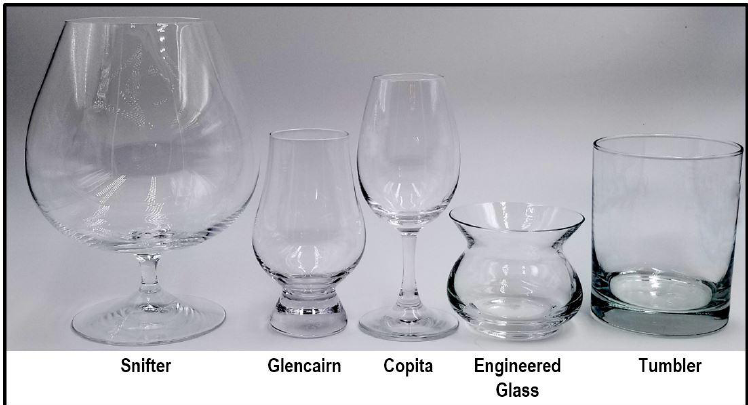
Figure 2. Testing vessels utilized in all experimentation.